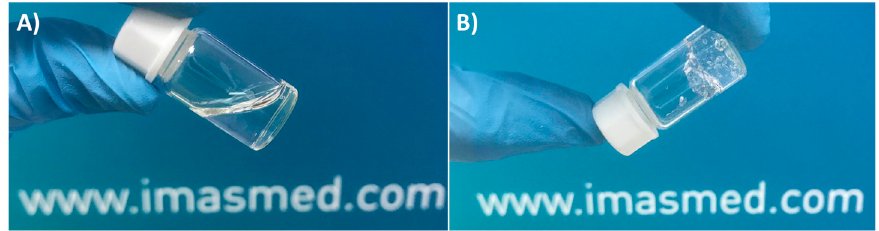
Figure 2. Example of a gelation time measurement by inverted vial method.